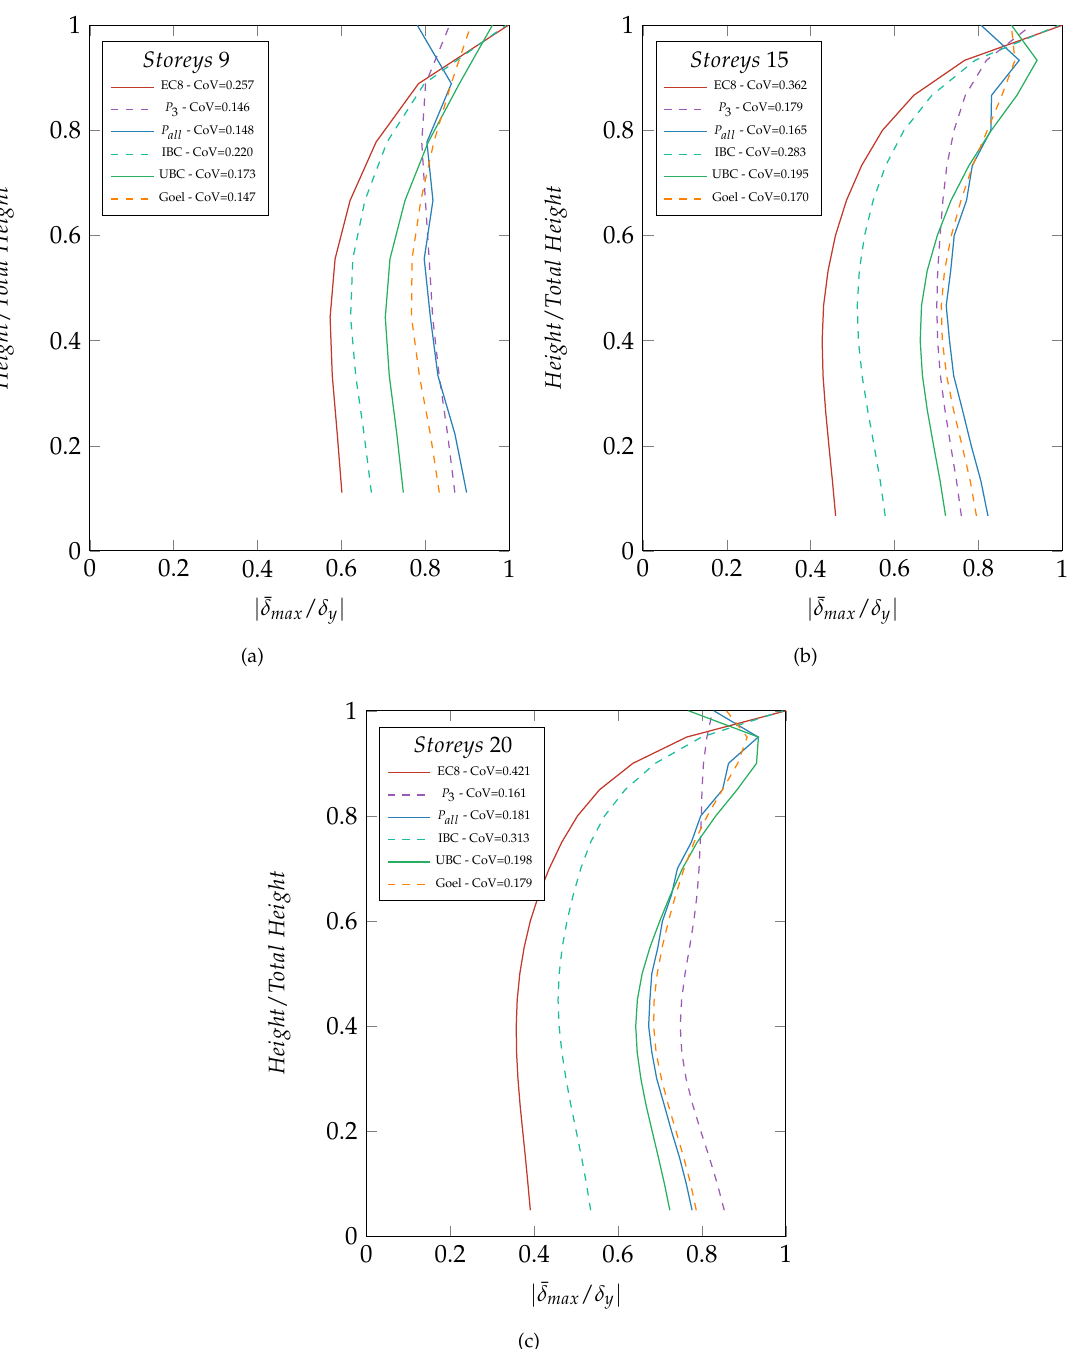
Figure 6. Mean maximum dimensionless inter-storey displacement distribution of the nine-storey ( a ), 15-storey ( b ) and 20-storey ( c ) SBM designed according to the 6 load